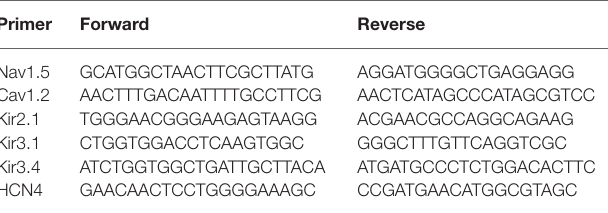
TABLE 1 | Primers used in